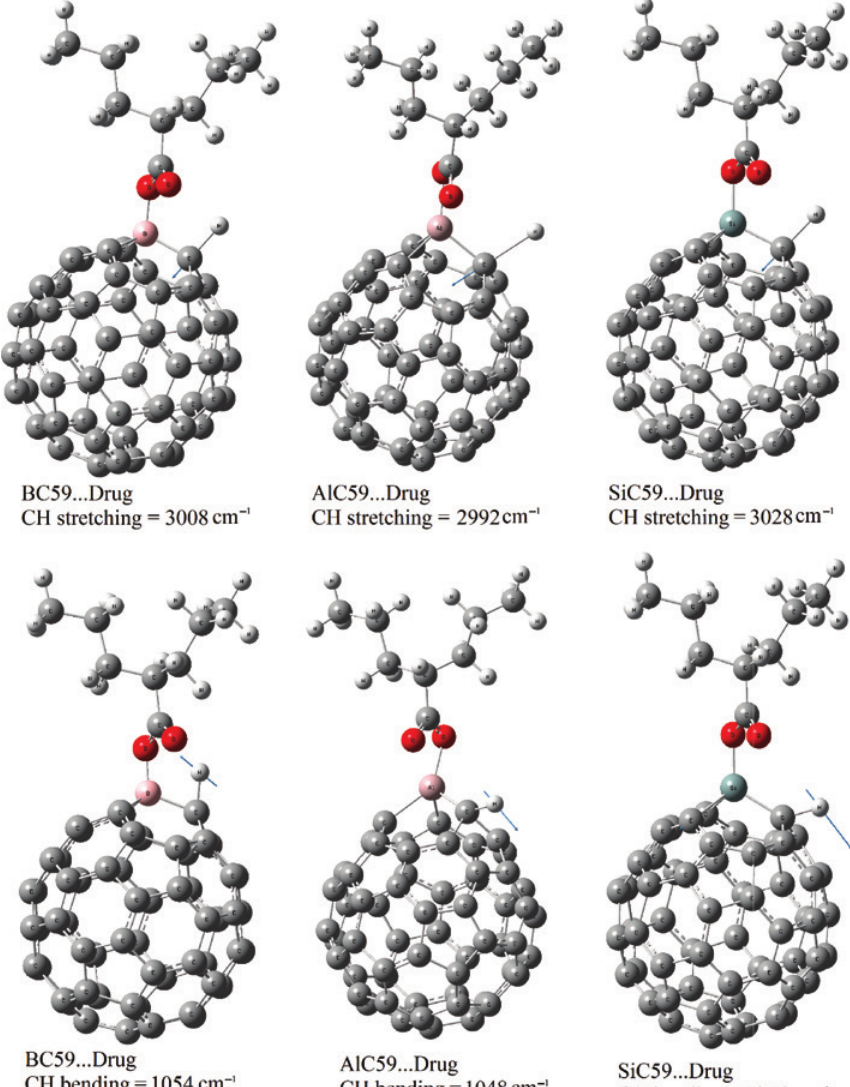
Figure 3: Diagnostic vibrational bands of the examined